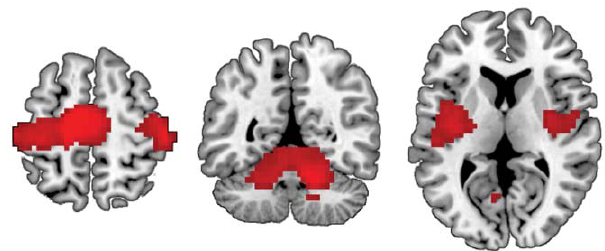
Figure 4. Whole-brain searchlight analysis of age differences in motor distinctiveness. Neural distinctiveness was significantly higher in young adults than in older adults in primary motor cortex, pre- supplementary motor area (left panel; z=56), cerebellum (center panel; y= 2 52), and insula (right panel; z=8). Coordinates are reported in MNI